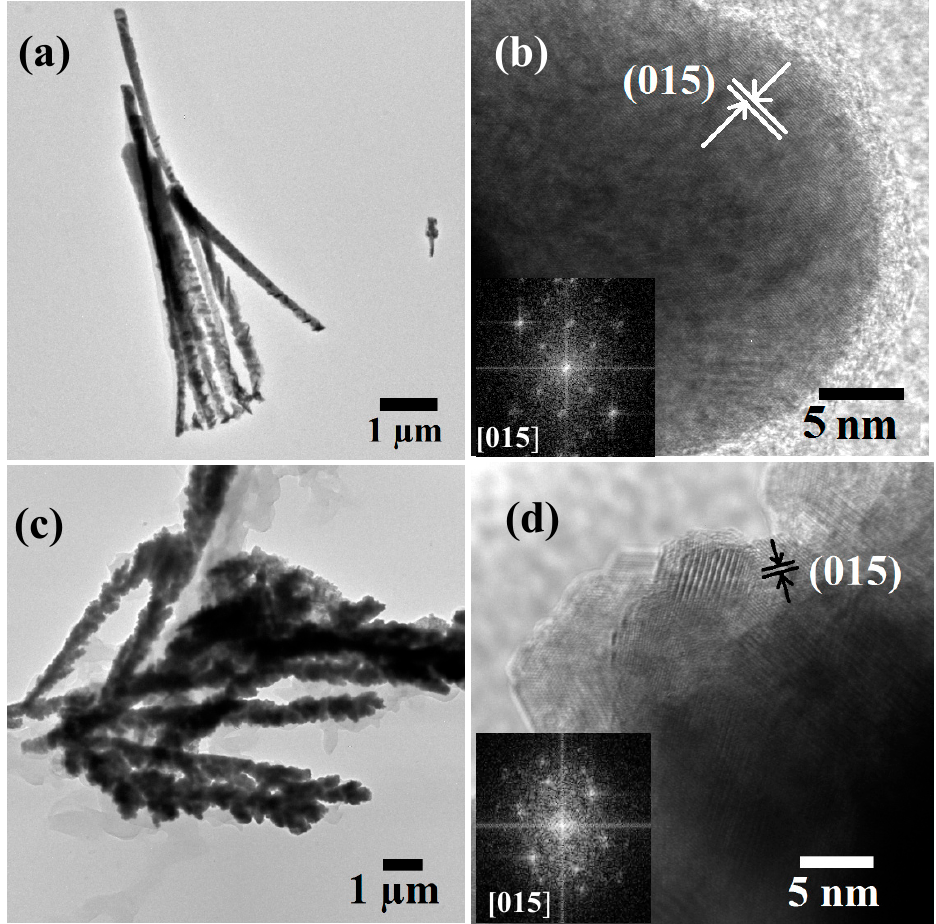
Figure 4. TEM and HRTEM images of ( a , b ) of Bi-rich Bi 2– x Sb x Te 3 NWs showing uniform and smooth surface texture composed of well crystalline spherical grains; ( c , d ) Sb-rich Bi 2– x Sb x Te 3 NWs with rough surface that are composed of highly crystalline faceted grains.